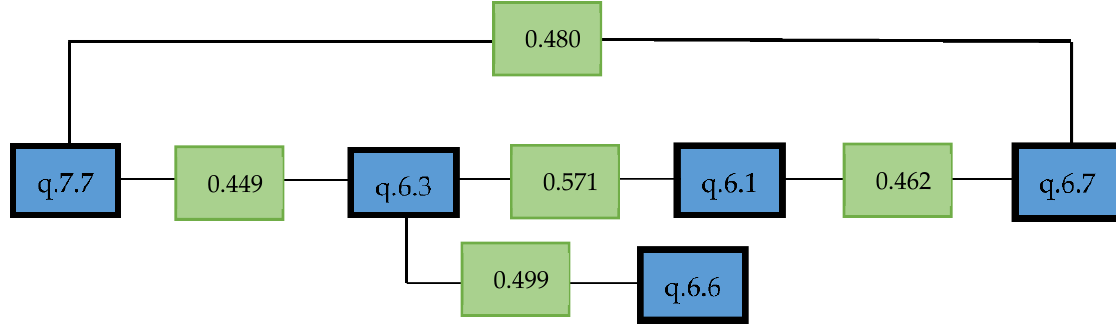
Figure 5. Correlational structure.